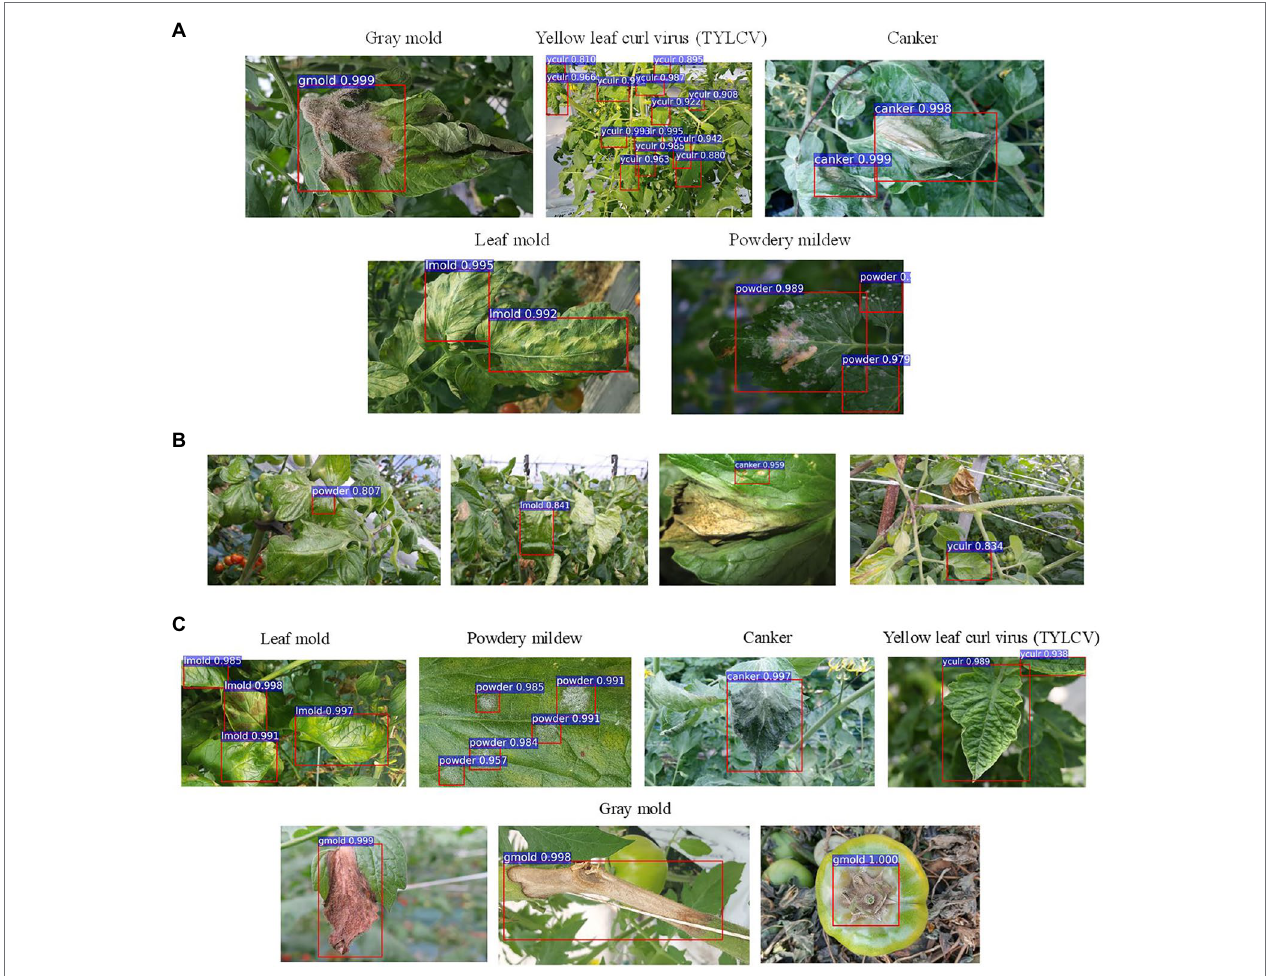
FIGURE 5 | Example qualitative results from different setups and experiments. (A) Examples of true positives obtained during training/validation with target and control classes. (B) Examples of false positives and undetected areas resultant from training the model without control classes. (C) Recognized target samples on the inference dataset. Class notations are introduced in Section “Criteria for Data Collection.”